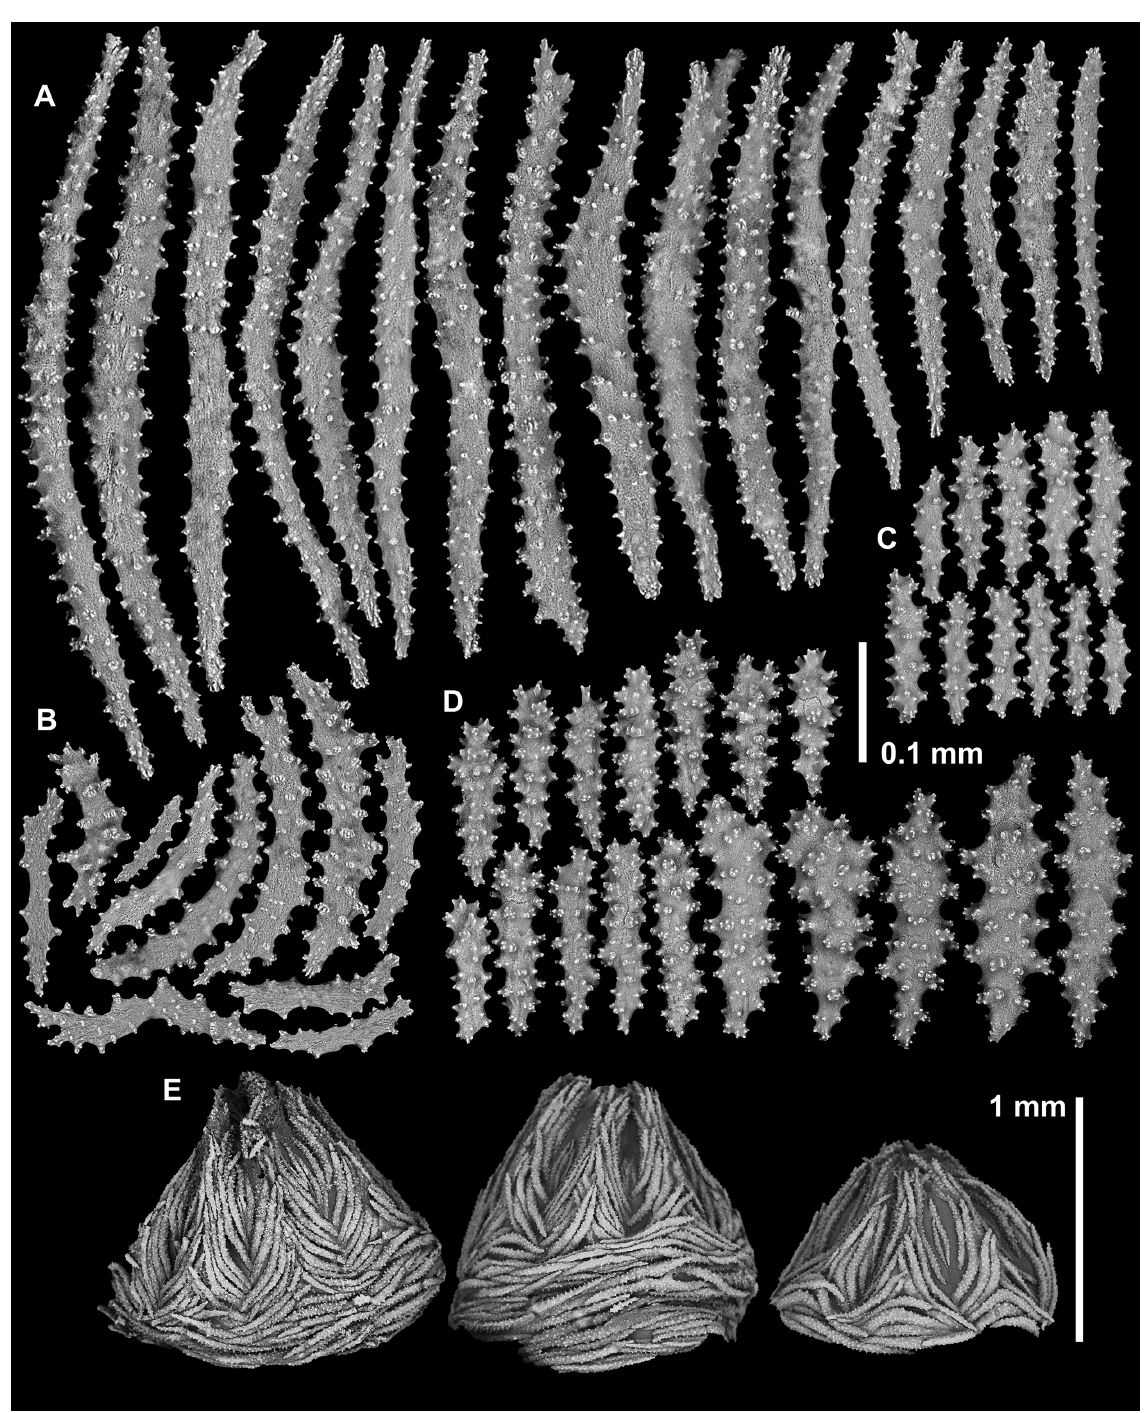
Fig. 29. Ushanaia ferruginea gen. et sp. nov., holotype (NIWA 156313), SEMs of sclerites. A . Collaret and points. B . Tentacles. C . Polyp neck. D . Polyp mound. E . Polyps (in